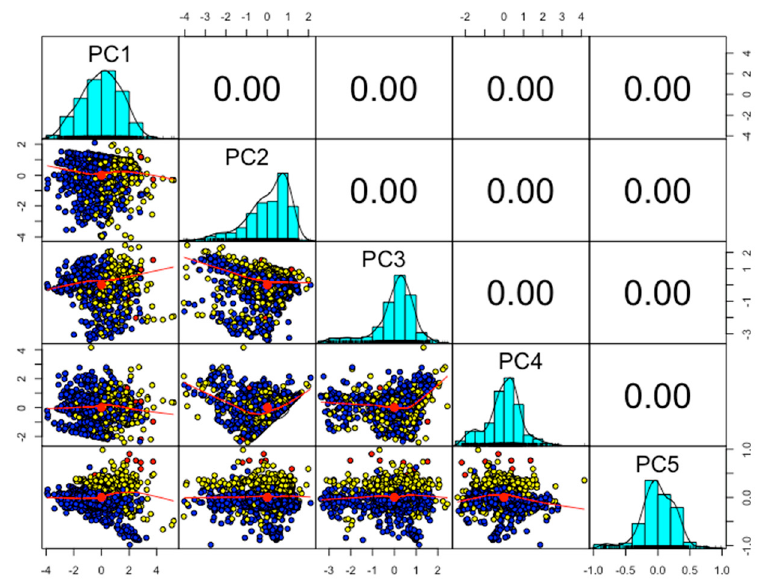
Figure 3. The linear uncorrelated principal components (PCs) from hourly wind turbine data.